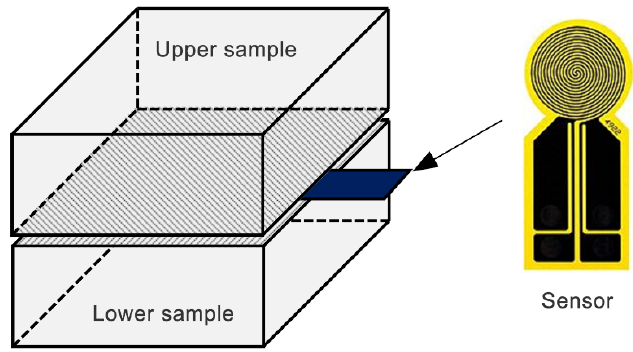
Figure 5. Principal experimental setup for the transient plane source (TPS) method and the sensor shape.